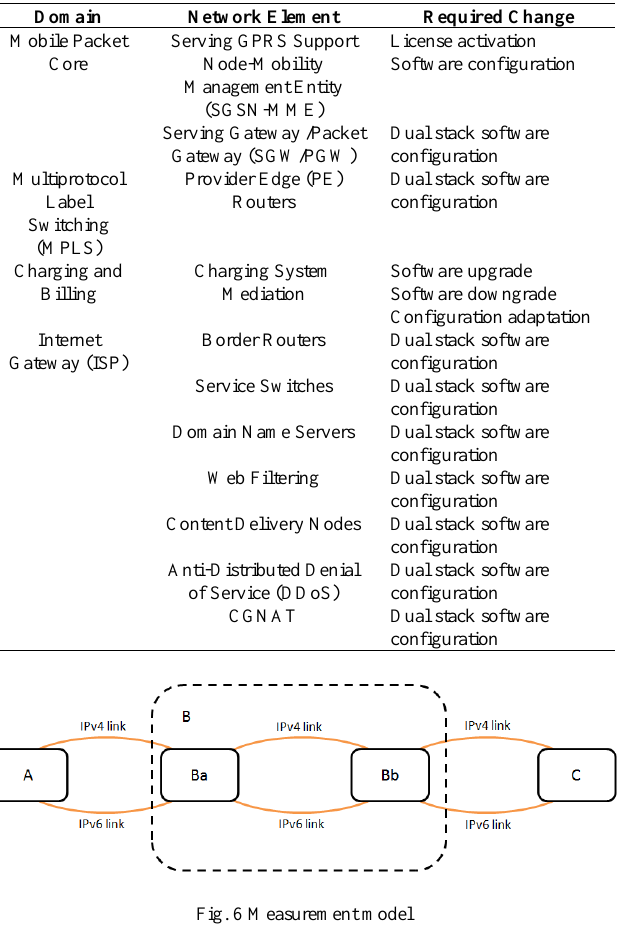
Table 3. Node level change requirement